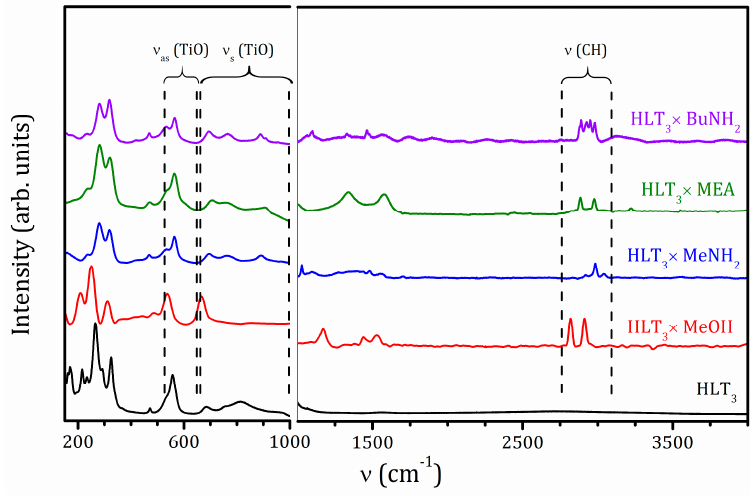
Figure 2. Raman spectra of the initial HLT 3 and organic-inorganic HLT 3 × MeOH, HLT 3 × MeNH 2 , HLT 3 × MEA, and HLT 3 × BuNH 2 compounds.